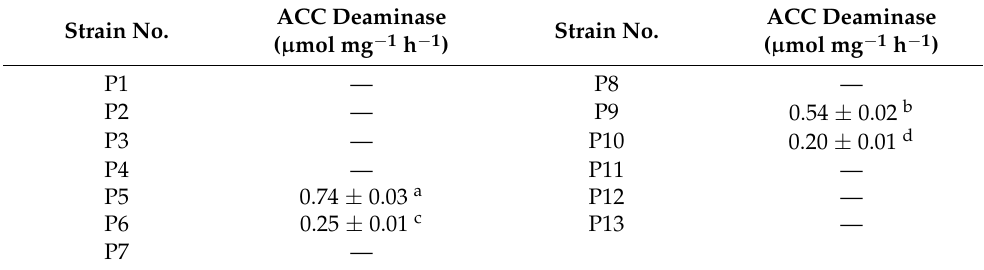
Table 4. 1-Aminocyclopropane-1-carboxylic acid (ACC) deaminase of phosphorus-dissolving bacteria. Strain